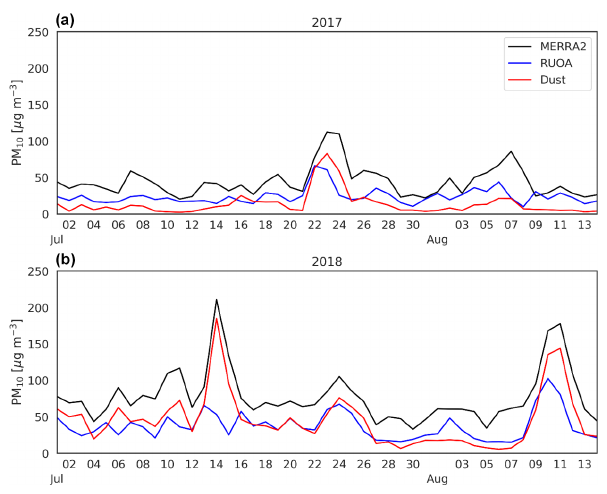
Figure 5. Daily mean of PM 10 estimated from MERRA-2 (black line), PM 10 measured by the RUOA station (blue line), and the estimated dust mixing ratio content from MERRA-2 (red line) for (a) 2017 and (b)